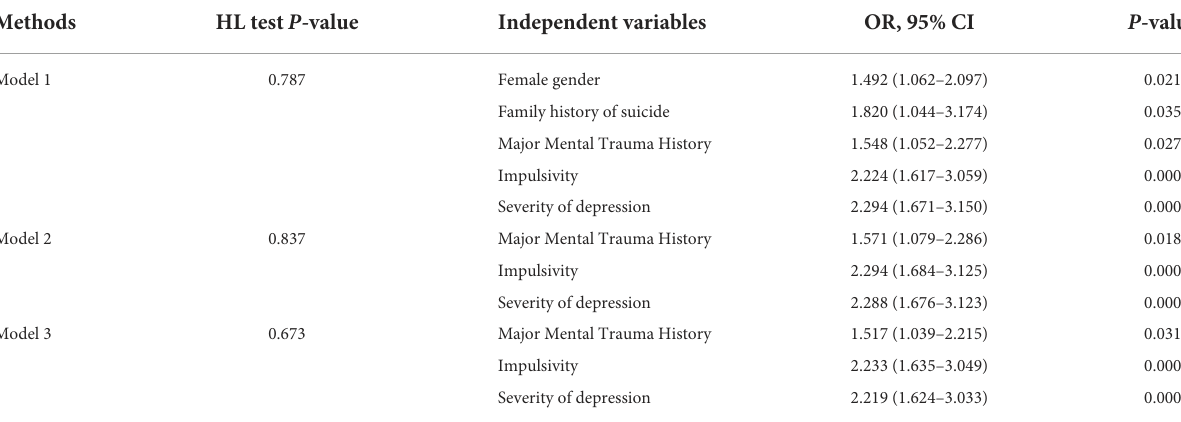
TABLE 2 Factors associated to the appearance of suicidal behavior among patients with MDD.